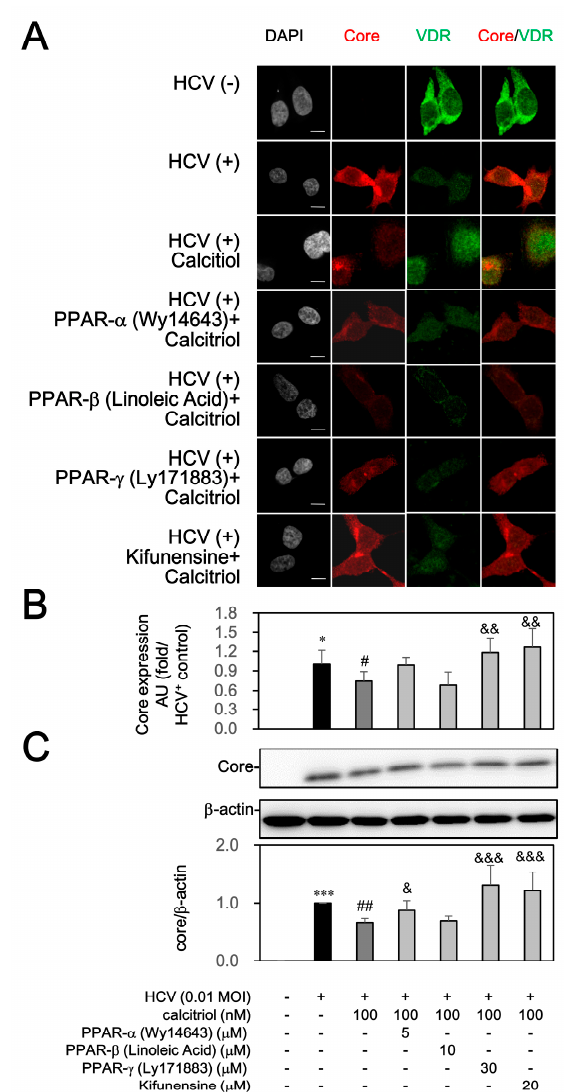
Figure 3. Effects of PPAR stimulators and ERAD inhibitor on calcitriol-mediated the core expression. ( A ) Huh7.5-SEAP cells (1.5 × 10 4 ) infected with HCV were treated with 5 μ M of Wy14643, 10 μ M of linoleic acid, 30 μ M of Ly171883, or 20 μ M of kifunensine for 1 h ahead of treatments with 100 nM of calcitriol for 6 days in a 24-well plate, fixed with 1% paraformaldehyde, stained with core and VDR antibodies and counterstained with DAPI. After staining, these cells were mounted on glass slides and observed under confocal laser scanning microscope. Scale bar, 10 μ M; ( B ) The arbitrary units (AU) of immunofluorescence intensity were assessed using Image J; ( C ) Cell lysates (7 × 10 5 ) were collected and the core level was detected by Western blot. Data are expressed as mean ± SD obtained from three individual experiments. * p < 0.05 and *** p < 0.001 vs. the Huh7.5 cells without HCV infection. # p < 0.05 and ## p < 0.01 vs. the HCV-infected Huh7.5-SEAP group. & p < 0.05, && p < 0.01 and &&& p < 0.001 vs. the calcitriol-treated group. The symbol (–) and (+) referred to the cells without and with HCV infection,